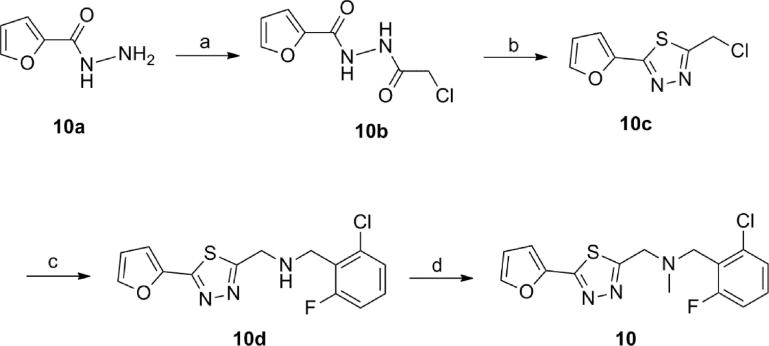
Synthesis of compound 10. Reagents and conditions: (a) N-methylmorpholine, chloroacetyl chloride, CH2Cl2; (b) Lawesson’s reagent, THF, reflux; (c) 2-Chloro-6-fluorobenzylamine, DIPEA, NaI, CH3CN, reflux; (d) MeI, NaH, DMF.